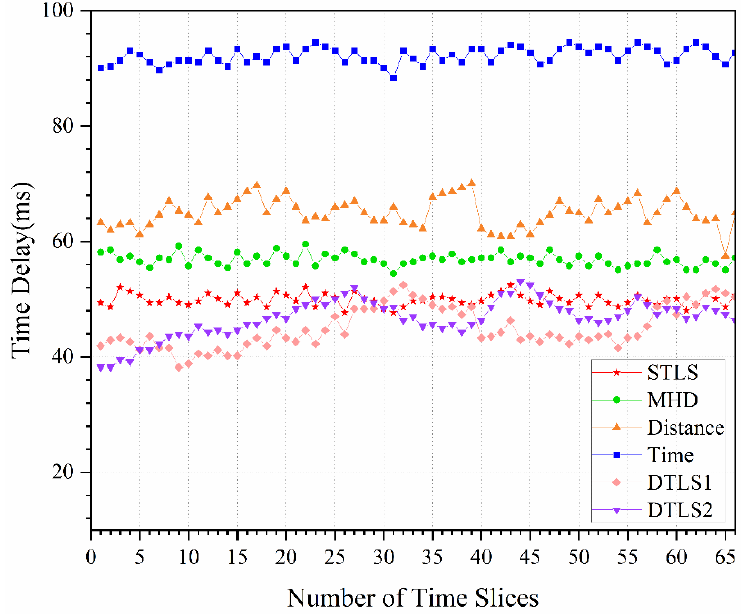
Figure 8. Comparison of the total delay in the cycle for the six topologies.